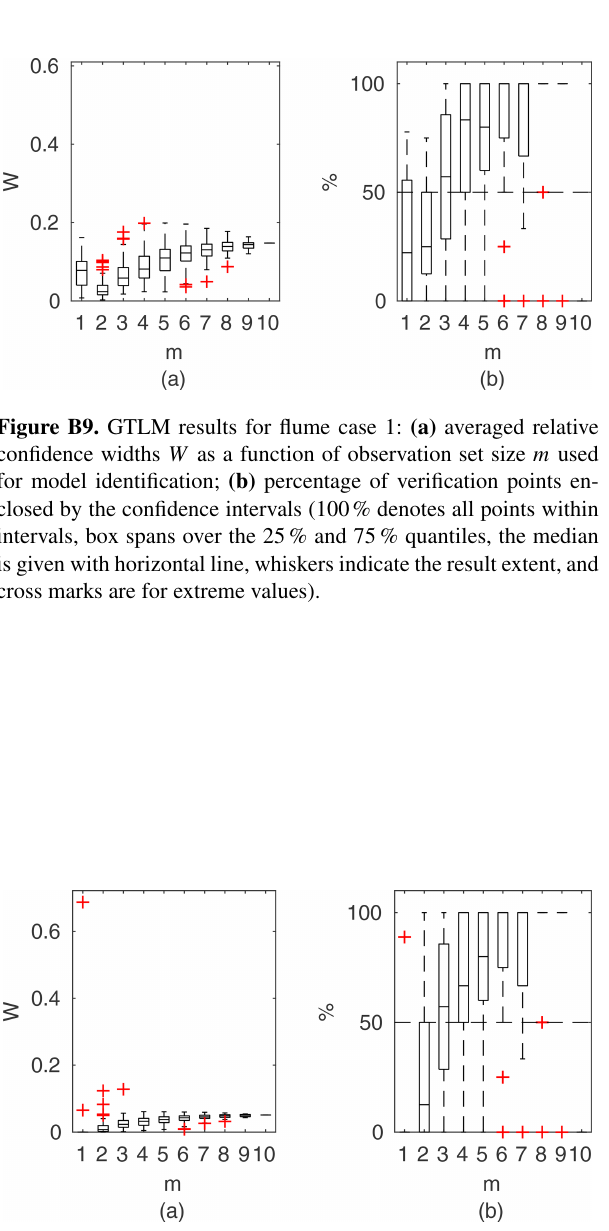
Figure B10. PTLM results for flume case 1: (a) averaged relative confidence widths W as a function of observation set size m used for model identification; (b) percentage of verification points en- closed by the confidence intervals (100% denotes all points within intervals, box spans over the 25% and 75% quantiles, the median is given with horizontal line, whiskers indicate the result extent, and cross marks are for extreme values).